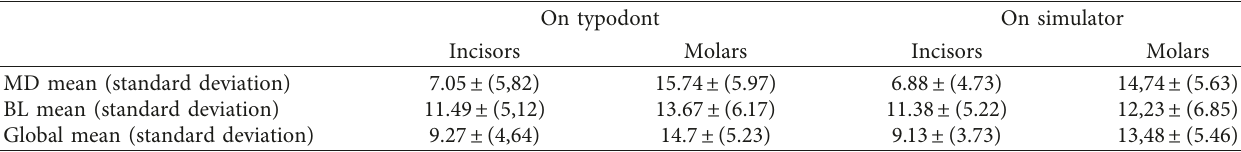
Table 3: Average TOC on typodont and simulator according to the type of teeth. On typodont